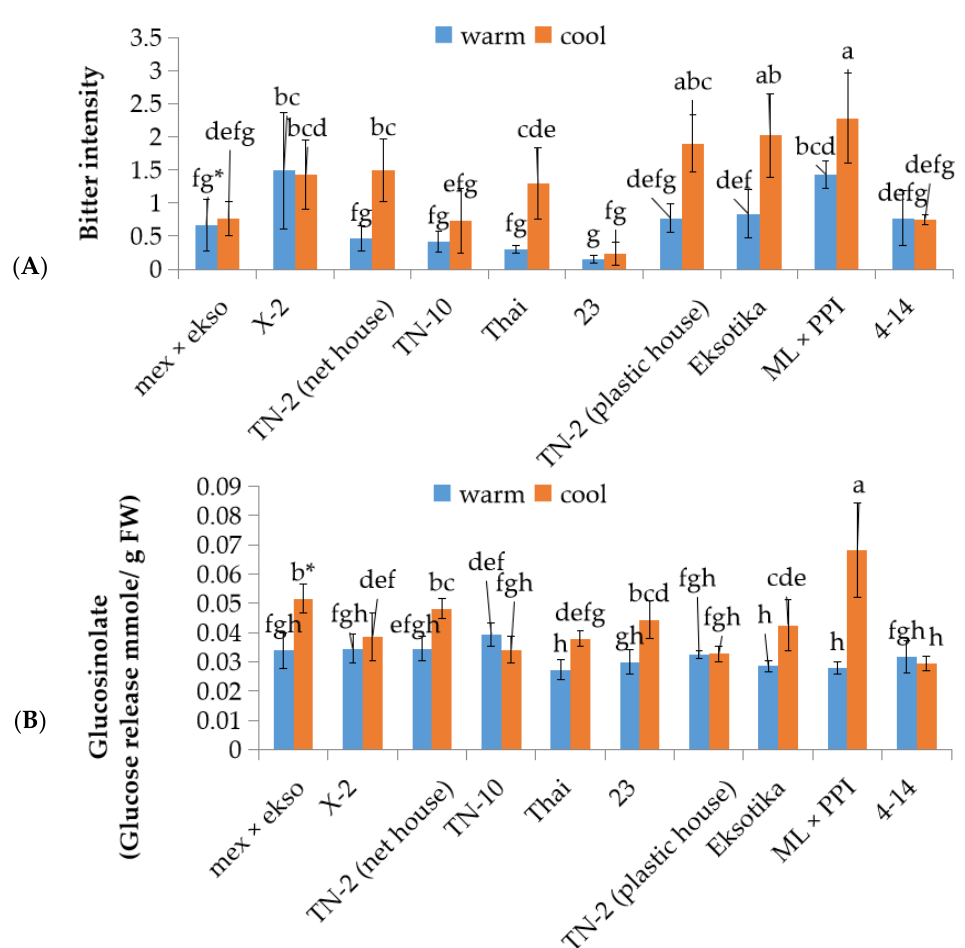
Figure 4. Bitterness intensity ( A ) and glucosinolate content ( B ) in different lines/cultivars of papaya fruit at first stage fruit development in the warm season and cool season. Data are mean ± SD, n = 4. * Mean statistical data within a column were obtained by Duncan’s test at the 5% level (same letters means no significance).